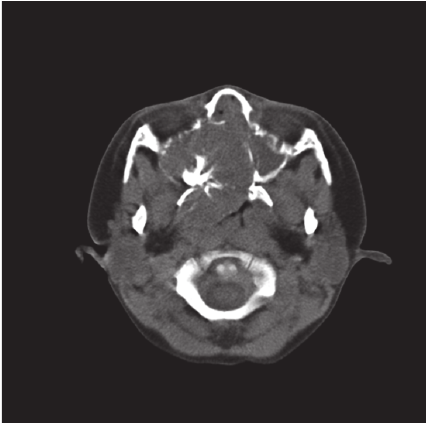
Figure 1: Precontrast axial CT scan shows a large round expansile mass hypoattenuating to the facial muscles and centered in the right maxillary sinus with plenty of calcifications.